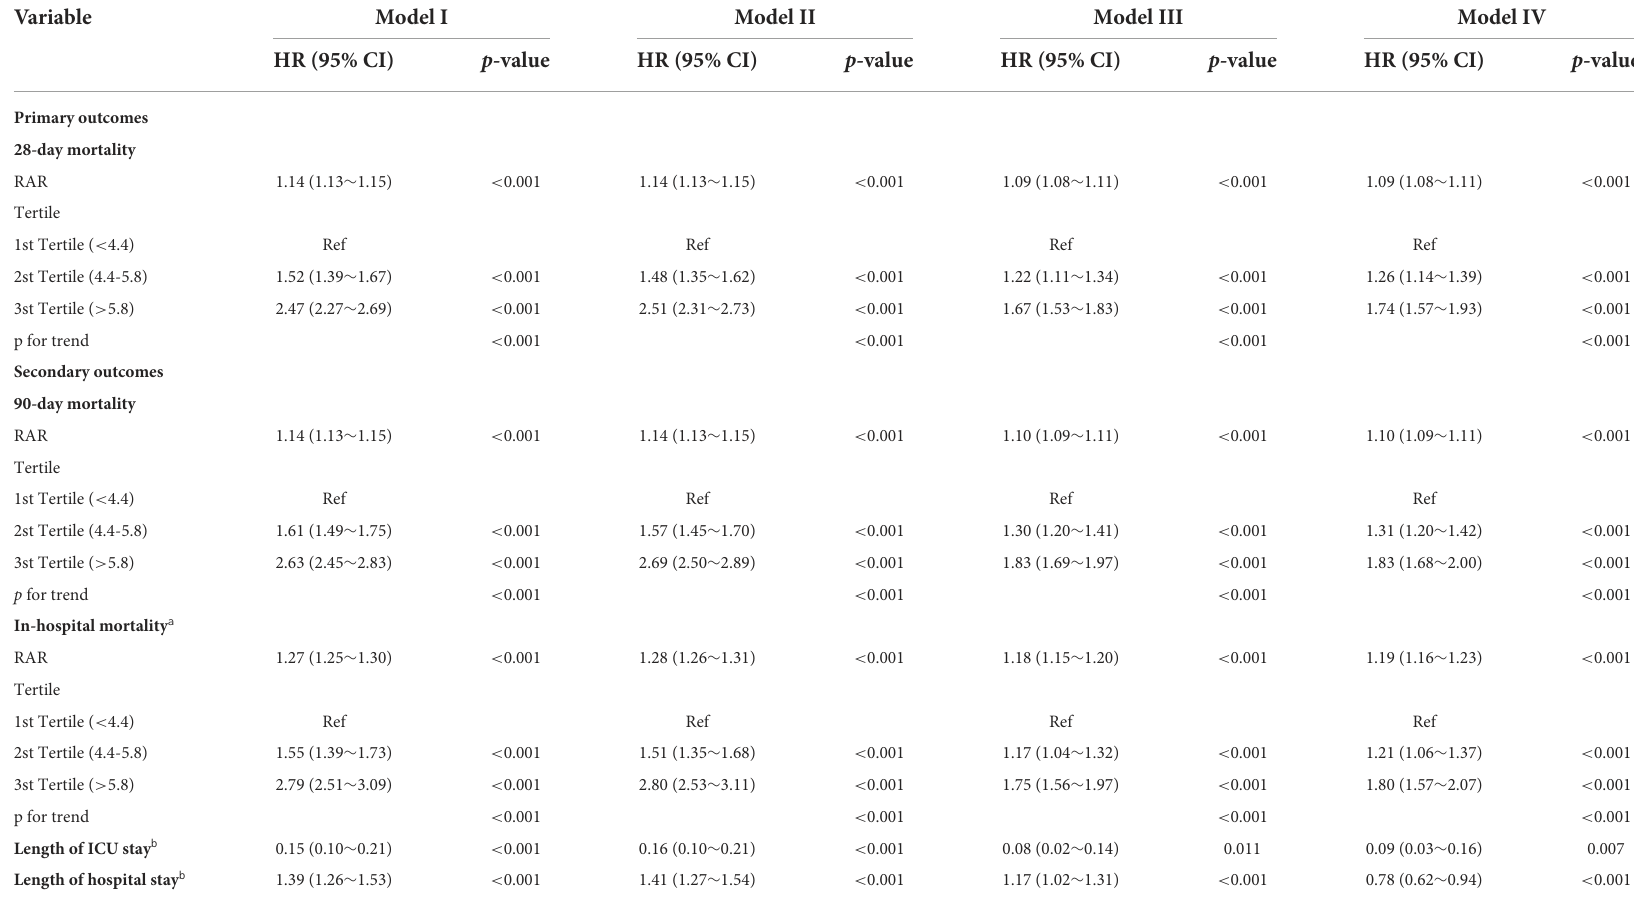
TABLE 2 Hazard ratio (HR) [95% confidence intervals (CIs)] for mortality across groups of ratio of red blood cell distribution width (RDW) to albumin (RAR) level.